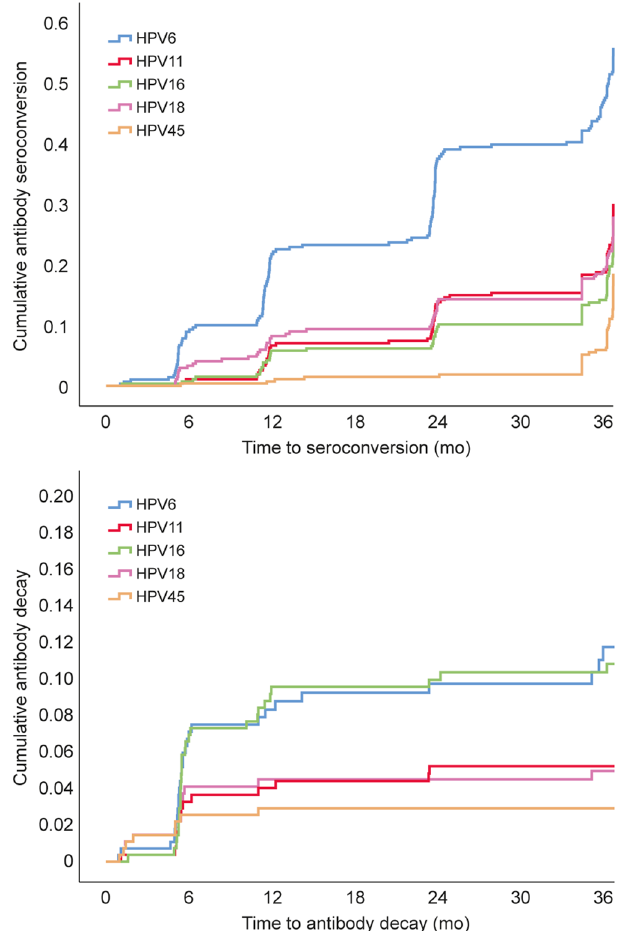
Figure 4. Cumulative seroconversion and antibody decay by HPV type in offspring during the first 3 years of life. Kaplan–Meier analysis showing 3 years cumulative antibody seroconversion (upper panel) and decay (lower panel) for HPV6, HPV 11, HPV16, HPV18 and HPV45